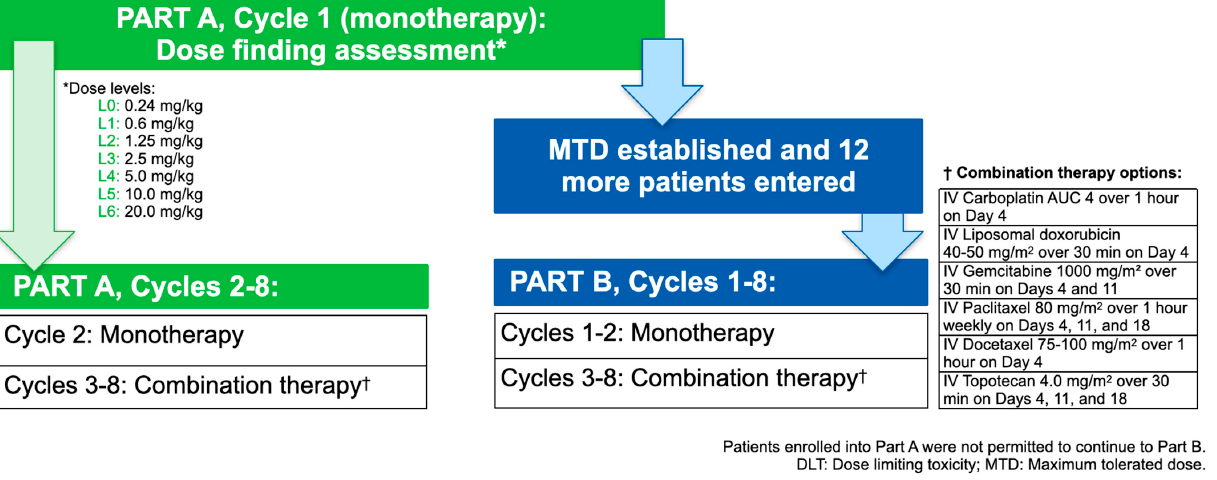
Figure 1. Schematic of the study design.